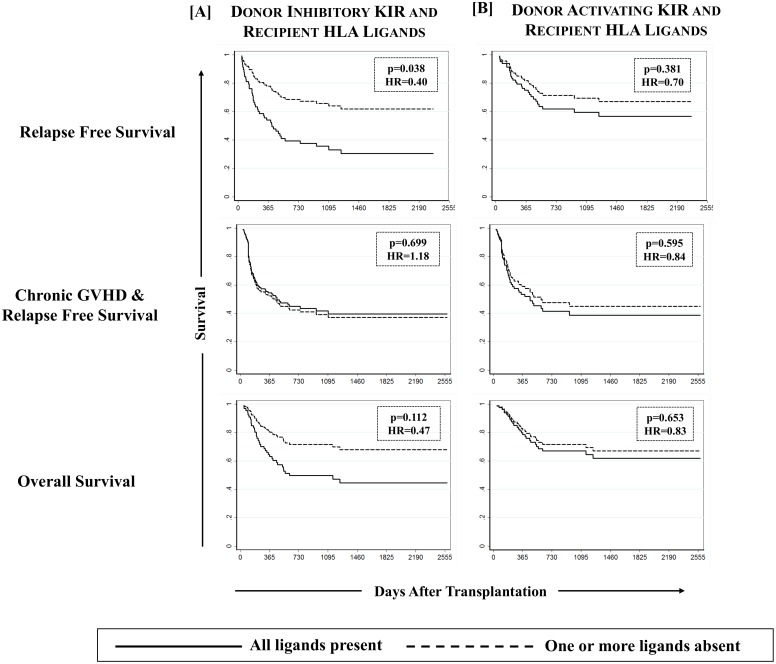
Effect of missing KIR ligands on relapse free survival among recipients of unrelated donor HCT.Multivariate cox proportional hazards regression analysis revealed a significantly improved relapse free survival (p-values <0.05) among recipients of unrelated donor HCT in which one or more HLA ligands for donor inhibitory KIR were absent. No effect on cGVHD & relapse-free survival (cGRFS) was noted whereas recipients with missing inhibitory KIR ligands experienced a comparatively better overall survival (OS), the difference however was not significant.